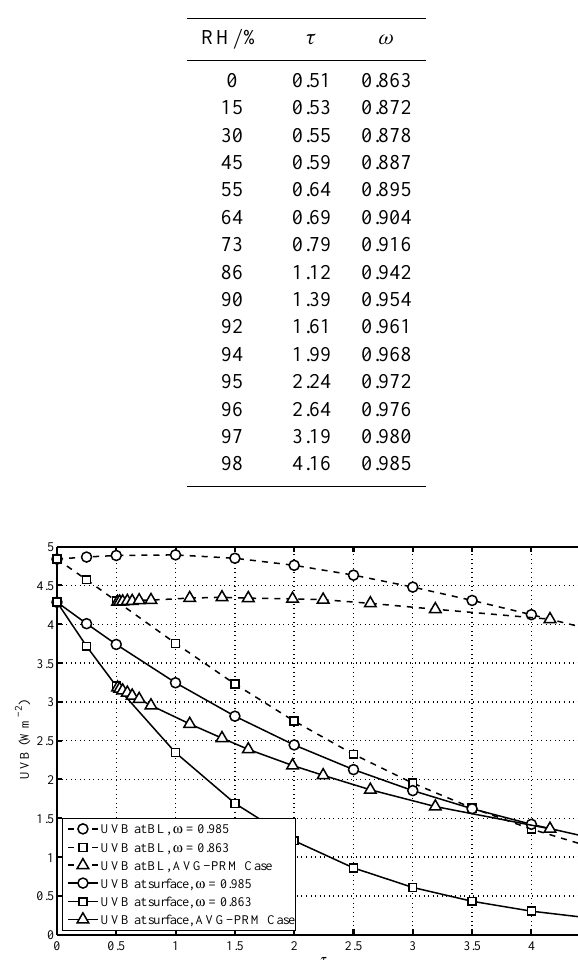
Table 4. The values of τ and ω at selected RHs from the AVG-PRM case.